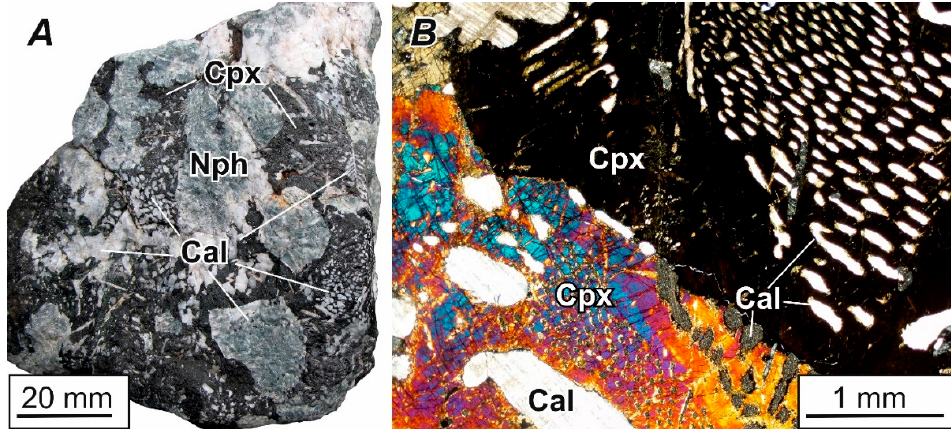
Figure 5. Representative photographs of clinopyroxene–calcite symplectites: Photo of a sample (Chk-270/5) ( A ) and a thin section with cross-polarized light ( B ). Mineral abbreviations: Cpx—clinopyroxene, Nph—nepheline, Cal—calcite.